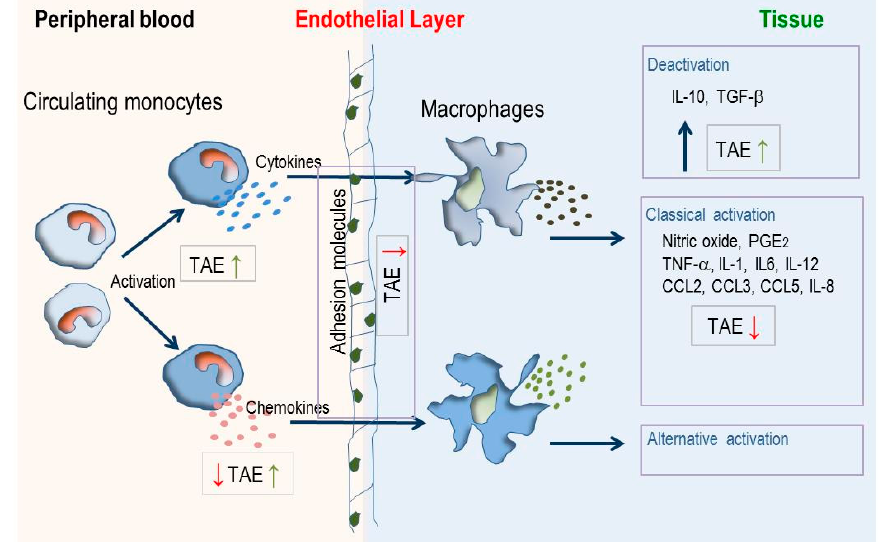
Figure 8. Modulation of inflammatory processes in blood and tissue by TAE. Circulating monocytes respond to activation signals (like pathogen associated molecular patterns, Toll-like receptor ligands, lipopolysaccharides) by increased production of cytokines and chemokines, migrate through endothelial layers and differentiate into tissue-resident macrophages. These can be stimulated by the classical or alternative activation pathway. TAE enhances (green arrows) or diminishes (red arrows) cytokines, chemokines and adhesion molecules which orchestrate cell trafficking, activation and differentiation in different compartments of the immune system.